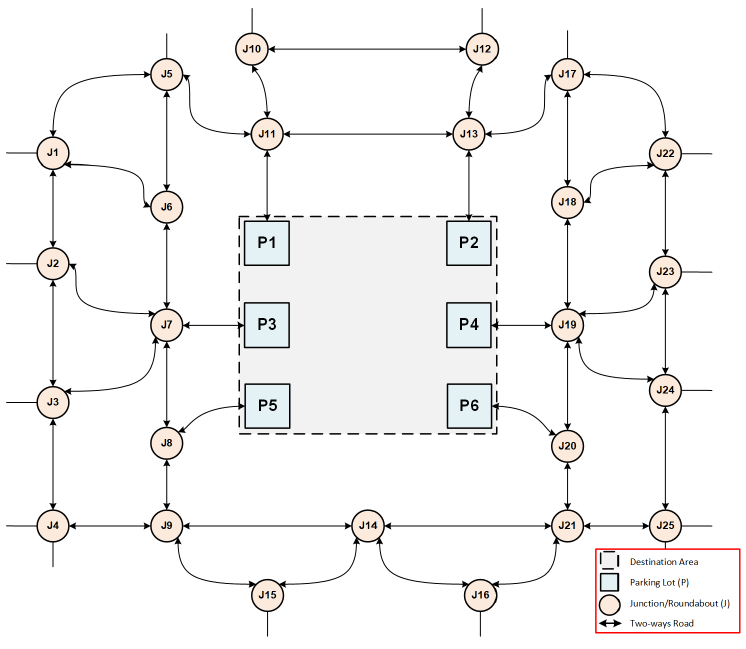
Figure 5. Simulation